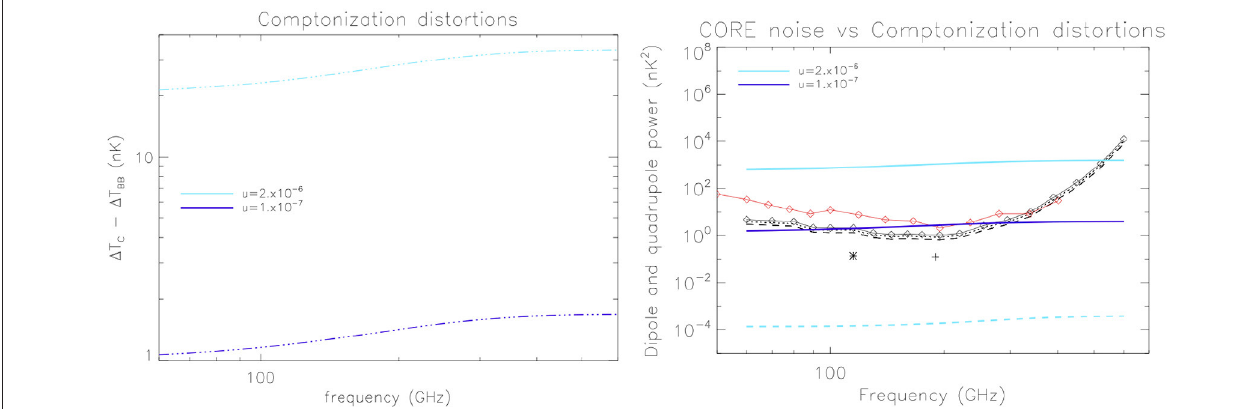
FIGURE 5 | Left : “spectrum of dipole (in equivalent thermodynamic, or CMB, temperature) expressed as the difference between that produced by a distorted spectrum and that corresponding to the blackbody at the current temperature T 0 . Thick solid lines (or thin three dots-dashes) correspond to positive (or negative) values.” Comptonization “distortions for u = 2 × 10 − 6 (upper curves) and u = 10 − 7 (lower curves), representative of imprints by astrophysical or minimal reionization models, respectively”, are shown. Right : APS of the dipole map, derived from the difference between distorted spectra and the current blackbody spectrum vs. CORE sensitivity. The CORE white noise APS (independent of multipole, shown as the black upper solid curve and with diamonds for different frequency channels) and its rms uncertainty (for ℓ = 1, using dots, and for ℓ = 2, using dashes) are plotted in black. The cross (asterisk) displays aggregated CORE noise from all channels (up to 220GHz). We shown also for comparison the LiteBIRD white noise APS (red solid curve and diamonds for different frequency channels). Again, Comptonization distortions for u = 2 × 10 − 6 (upper solid curve for the dipole map and bottom dashed curve for the quadrupole map) and u = 10 − 7 (lower solid curve for the dipole map) are displayed. Reprinted from Burigana et al. (2018) [ © SISSA Medialab Srl. Reproduced by permission of IOP Publishing. All rights